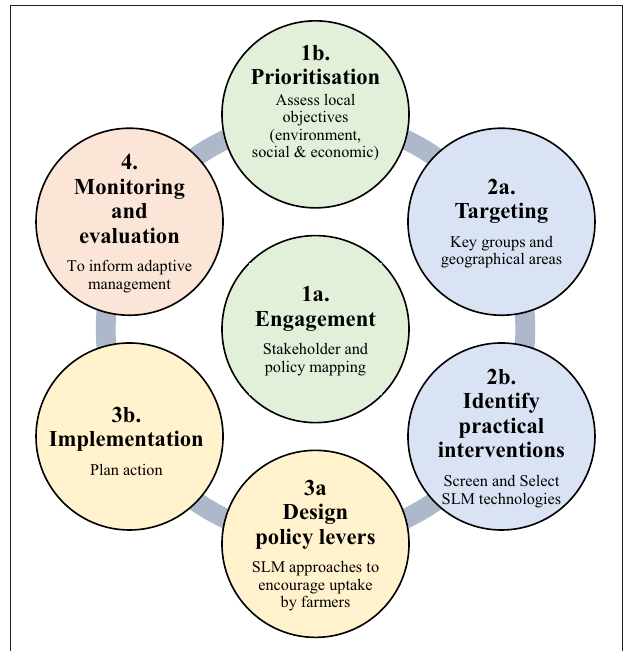
FIGURE 1 | Idealised policy/programme design cycle for integrated landscape management. This provides a typology of decisions and design phases. Decision approaches and toolkits to support each of the seven stages are sketched out in Table 3 .